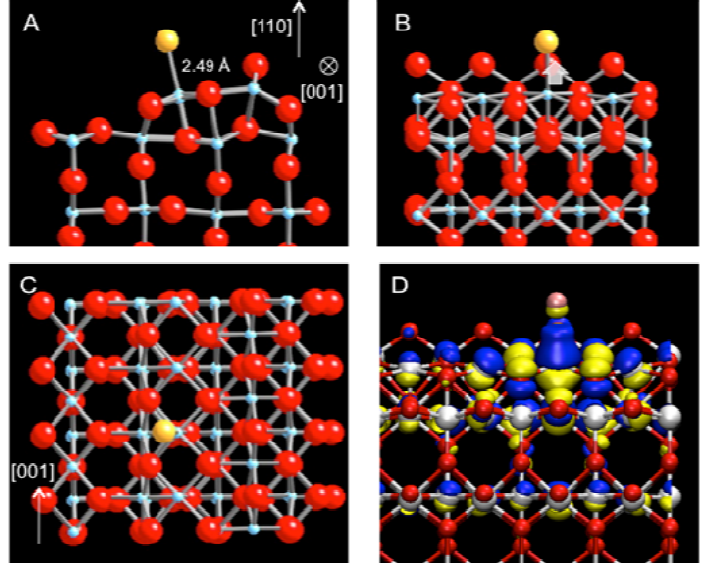
Figure 3. DFT-relaxed structure of Au adsorbed at an alternative site on the sub-stoichiometric strand defect viewed along ( a ) [001], ( b ) [1–10], and ( c ) [ − 1–10] (Au: yellow, Ti: blue; O: red). ( d ) The charge density difference isosurface plot of ( b ) revealing electron surplus (blue) and depletion